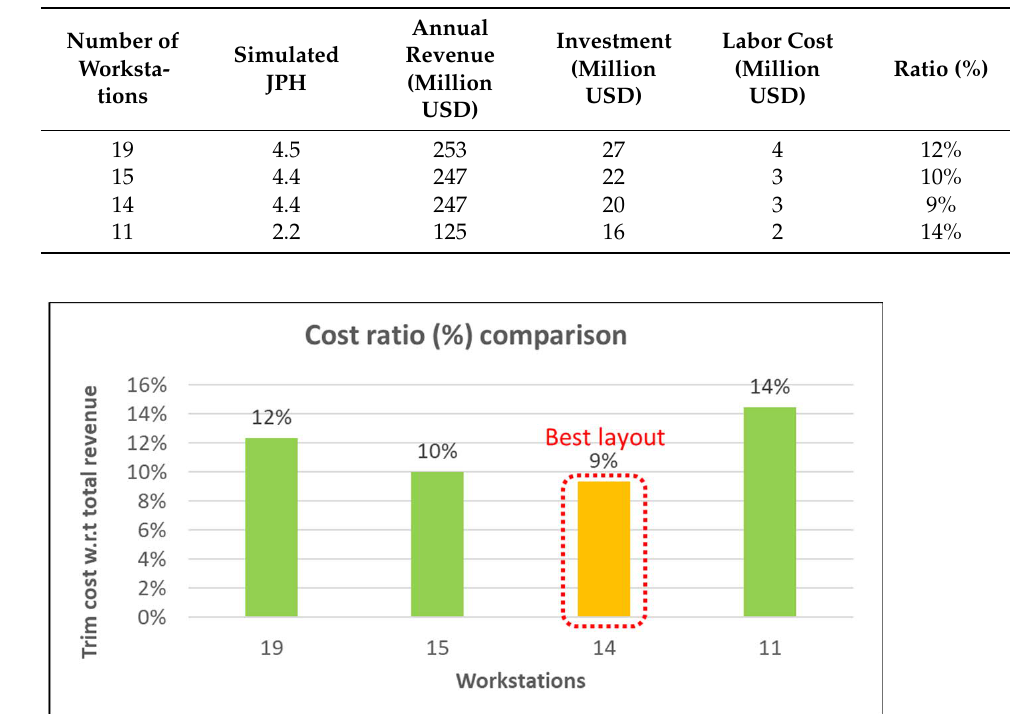
Table 2. Layout variants, each with cost ratio (%) of trim area w.r.t. total revenue.